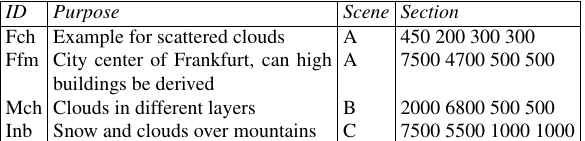
Figure 8. Resulting DEMs, rows: scale 1, 2, 4, columns: DEMs from bands (2,3), (2,4) and (3,4) respectively